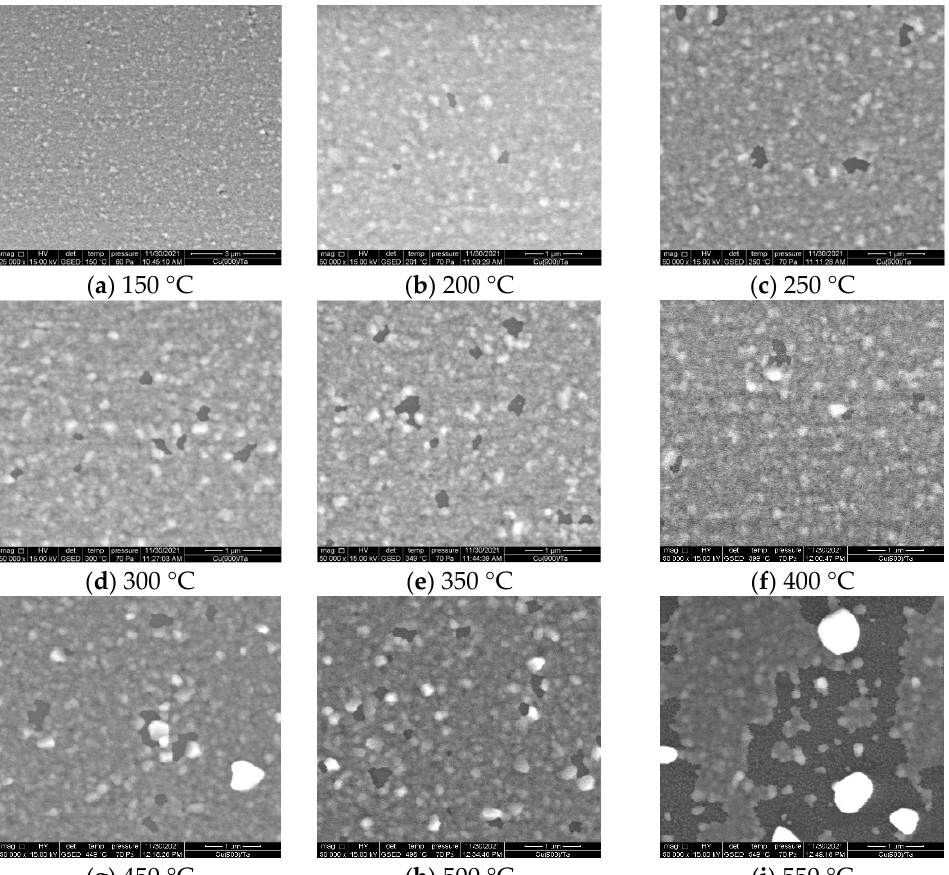
Figure 5. Surface of the Cu film deposited over a Ta layer from 150 °C ( a ) to 550 °C ( i ), using a 10 °C/min. heating rate.